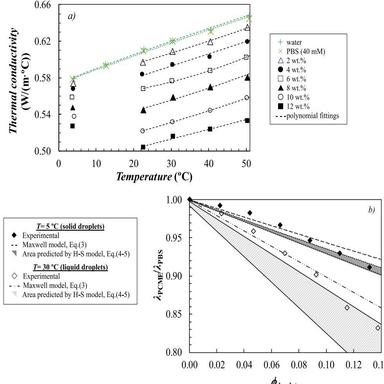
(a) Temperature dependence of thermal conductivity and (b) relative thermal conductivity (defined here as λPCME/λPBS ratio) as a function of volume fraction, ϕdroplets.